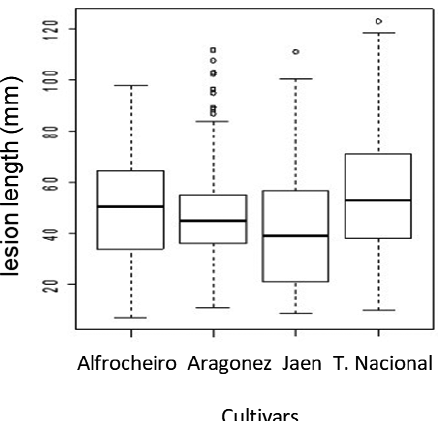
Figure 3. Boxplots of the average lesion lengths recorded for the four grapevine cultivars. The median is represented by the solid line.